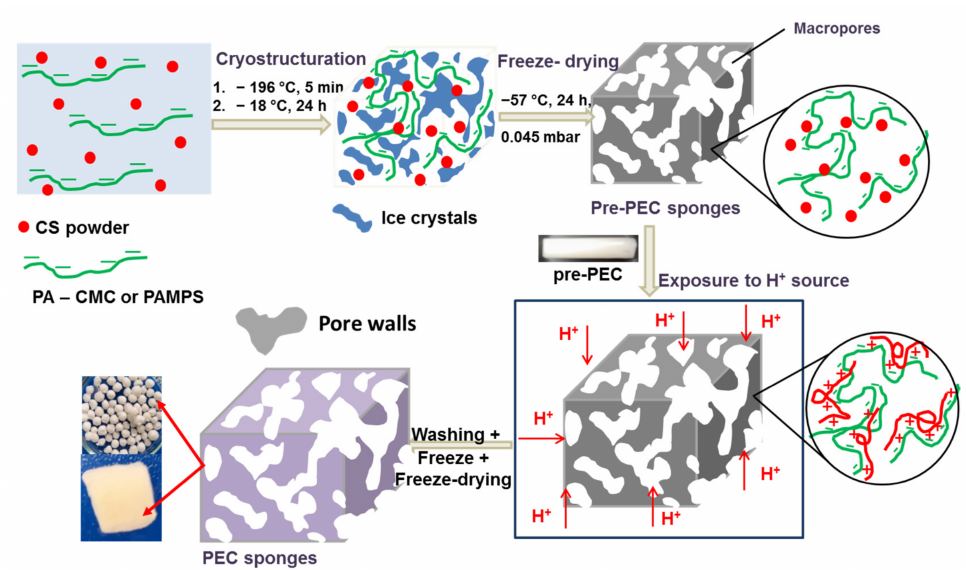
Figure 2. Main steps in the preparation of PEC sponges according to the strategy developed in this